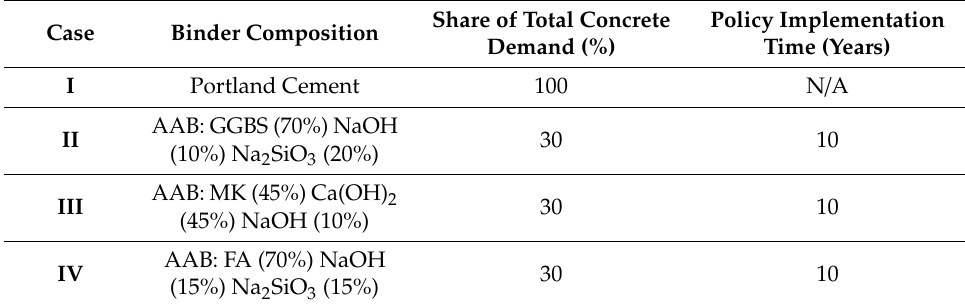
Figure 14. The effect of the single precursor system on net emissions released in ( a ) Low Variability Scenario; ( b ) High Variability Scenario; ( c ) Carbon Tax Increase Scenario; ( d ) Population Stabilization Scenario. Table 2. Single precursor system with optimal hybrid activator mix.